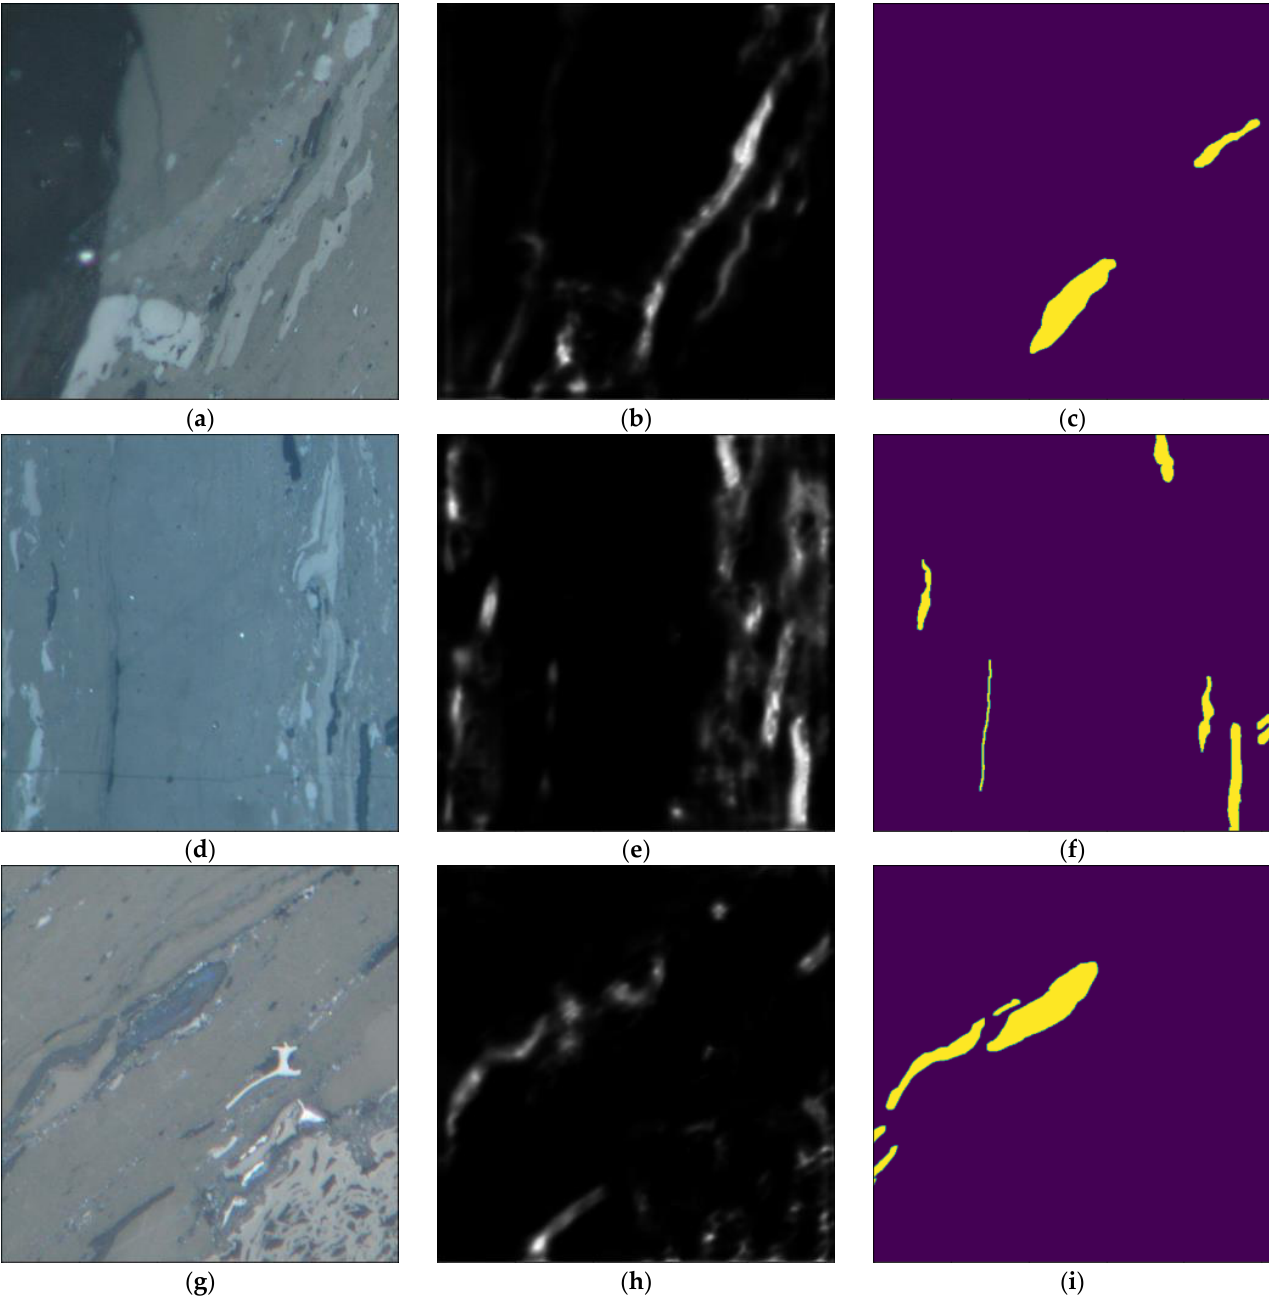
Figure 8. The results of liptinite segmentation. ( a , d , g ) Input images; ( b , e , h ) segmentation results; ( c , f , i ) ground truth.